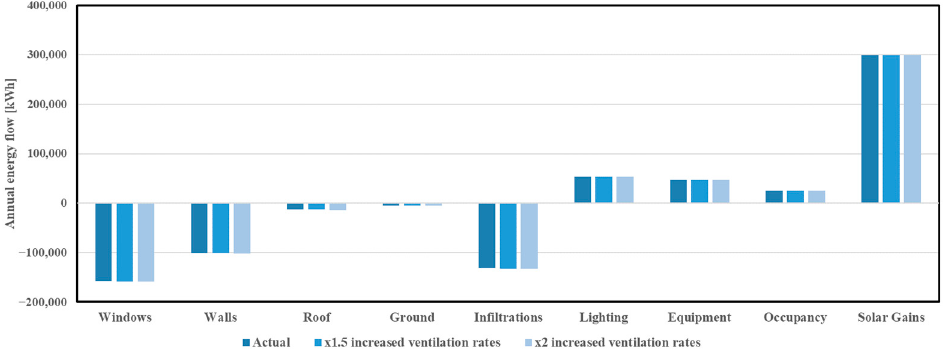
Figure 8. Estimated annual energy flows for the current building and increased ventilation rate cases.